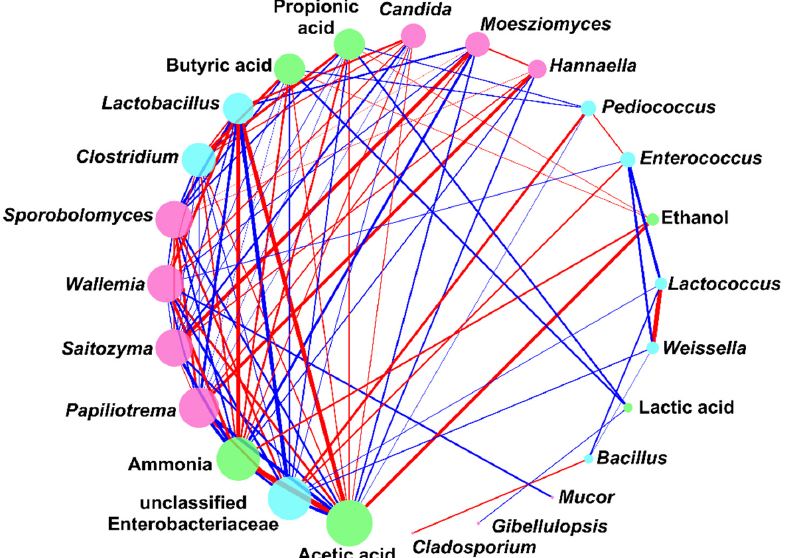
Figure 5. Correlation network diagram for fermentation products and major bacterial and fungal genera of direct-cut and wilted guinea grass silage. Green, blue, and purple nodes represent the fermentation product, bacterial genus, and fungal genus, respectively. The node size represents the degree of centrality, which is calculated as the number of edges connecting a node to others. The Spearman’s Rho of two nodes is indicated by the edge width, with red and blue edges describing the positive and negative relationships between the two nodes.